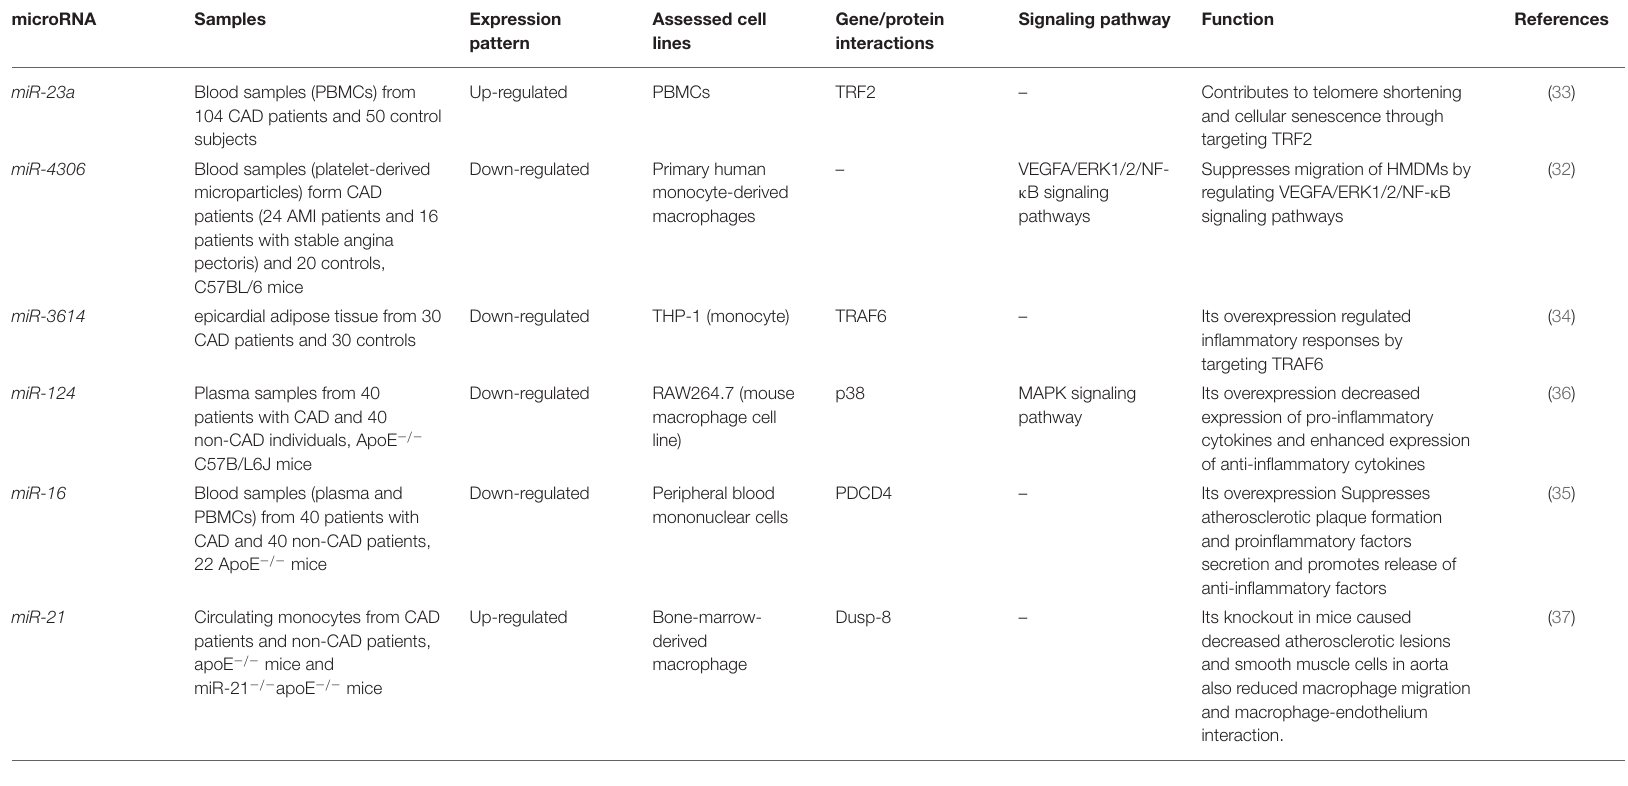
TABLE 3 | CAD-related miRNAs whose function has been assessed in macrophages/